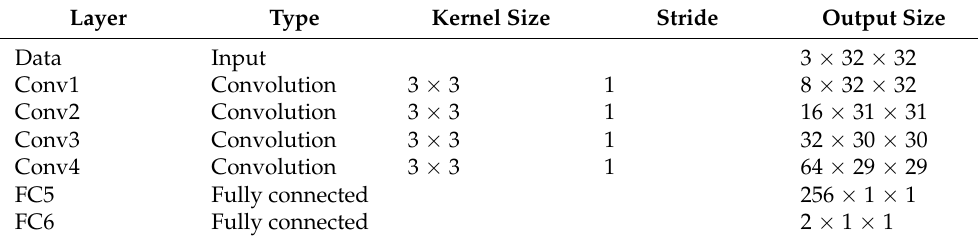
Figure 9. The architecture of the proposed CNN in the multi-patch-based model. Table 4. The configuration of CNN for the multi-patch-based model. Layer Type